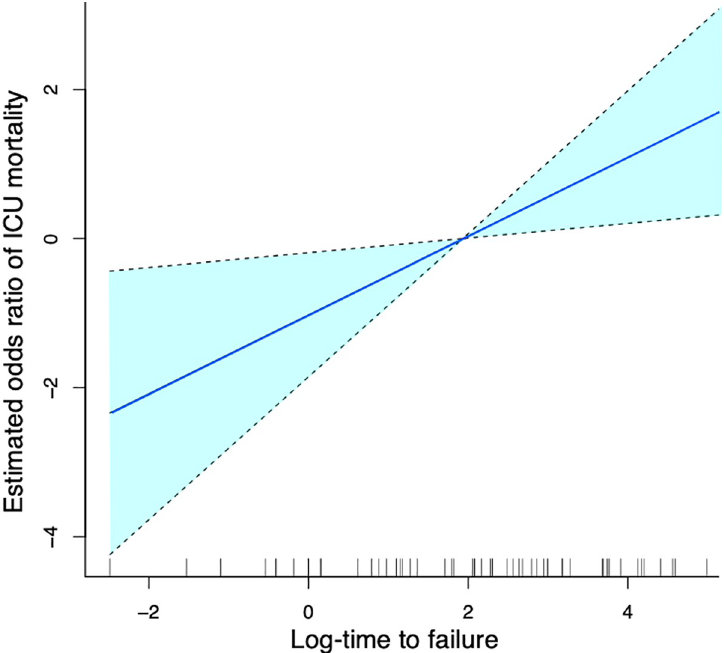
Fig 3. Spline curve in log odds ratio on the effect of log-time to failure on ICU mortality. Spline curve was plotted by using 3 adjusting factors (age, SOFA score, and PaCO2 before intubation). Dotted line means 95% confidence interval.